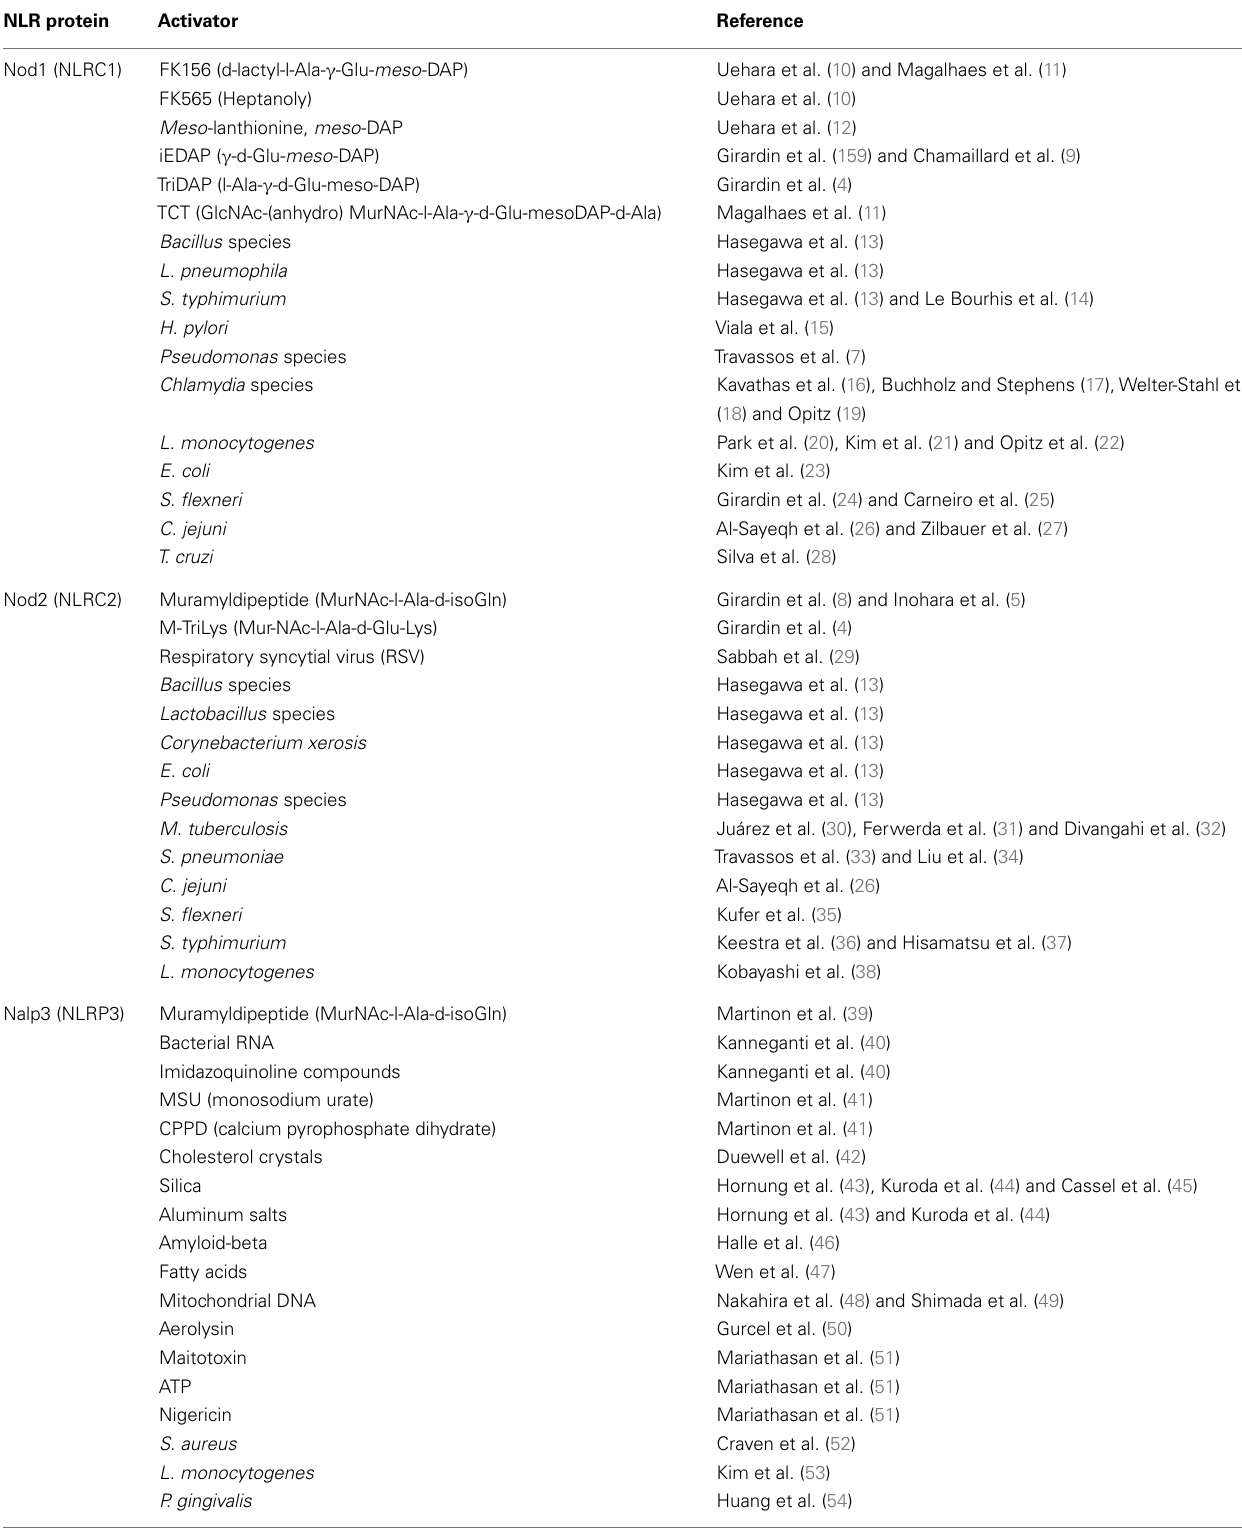
Table 1 | NLR proteins involved in autophagy and their